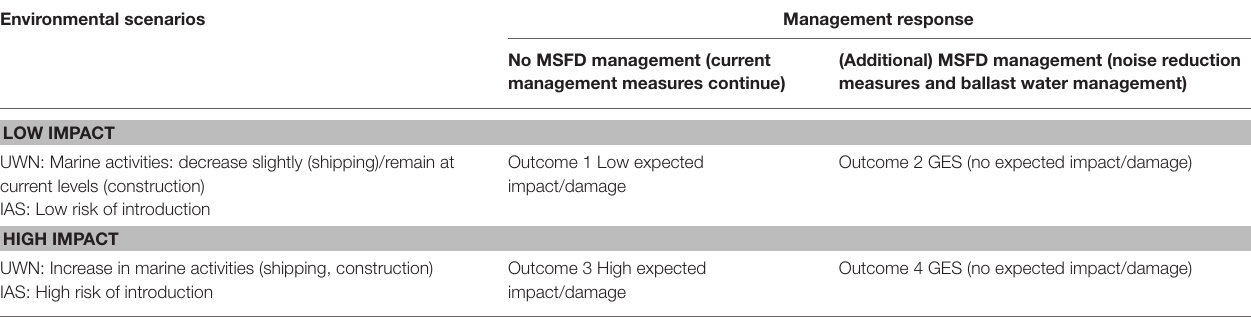
TABLE 5 | Development and definition of scenarios in the UK case study. Environmental